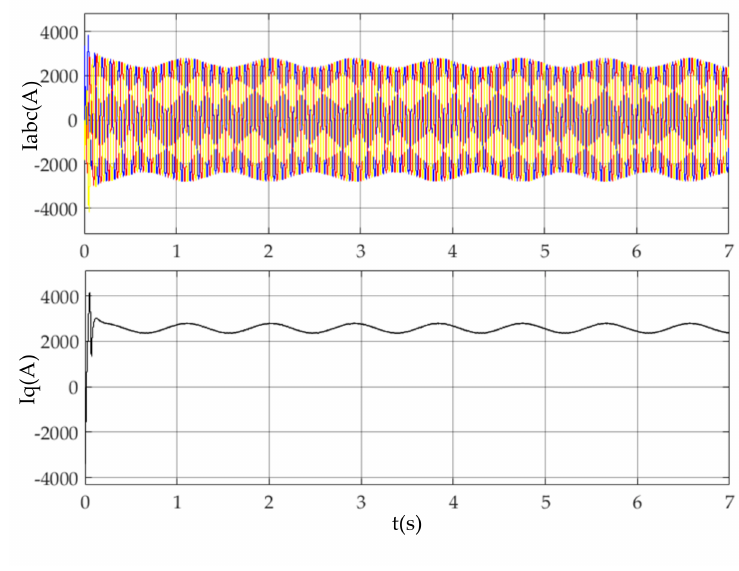
Figure 9. The waveform of stator